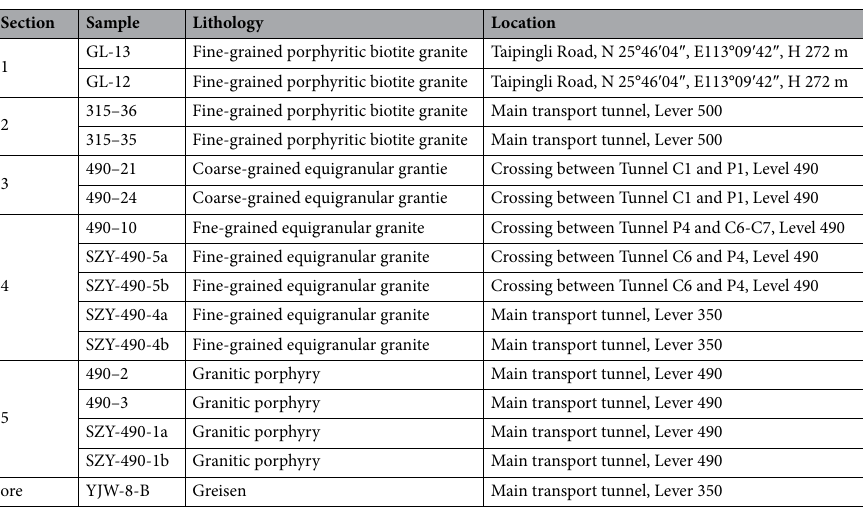
Table 6. Lithology and location of